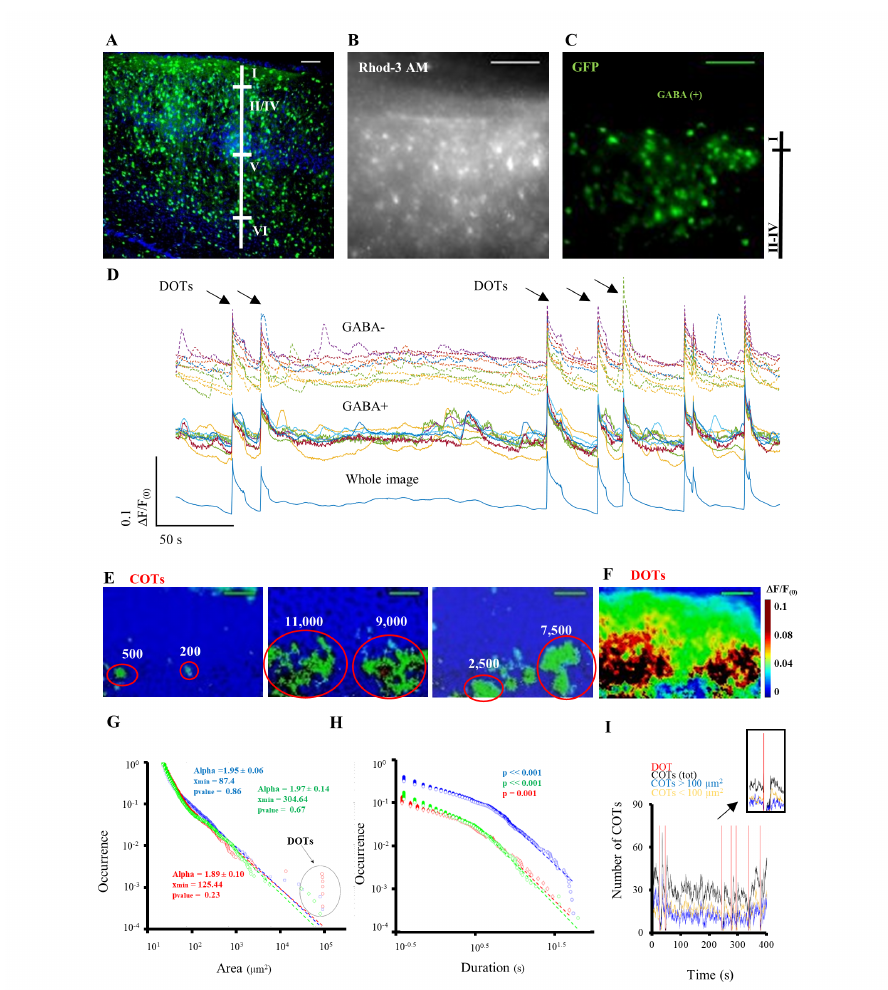
Figure 1: Spontaneous calcium transients in the cortex. (A) Fluorescent image of cerebral cortex from a GAD67-GFP mouse (P5) with DAPI nuclear staining; GABA+ neurons are labeled in green. The white vertical bar indicates the putative layers. (B) Organotypic slice from the same mouse line loaded with the fluorescent indicator Rhod-3 AM during calcium imaging, and corresponding GABA+ neurons (C) in the same field of view. The black vertical bar on the right indicates the approximate limits of cortical layers in this example. (D) ΔF/F (0) traces from the whole image (blue trace at the bottom, defined as ΔF/F network ) and from selected GABA+ (colored traces in the middle) and GABA- neurons (colored traces on top) from a calcium imaging recording. (E) Examples of Confined Optical Transients (COTs) from the pseudo-color ΔF/F (0) movie of the recording, showing isolated regions of variable sizes (see red circles; the rounded numbers are expressed in µm 2 ). (F) Example of Diffuse Optical Transient (DOT), where the increase in ΔF/F network involves more than 50% of the imaged slice. Color bar on the right. Scale bars: 80 µm in both fluorescence and pseudo-color images. (G, H) Probability distribution of area and duration of COTs in the cortex. Circles, rhombus and asterisks represent data from three representative experiments: the corresponding dotted lines in (H) show the linear fitting for each distribution. DOTs are visible as resonances outside the area’s distributions (see black circles). Insets indicates test of power law hypothesis and, only if p > 0.1, power point slope (alpha) and onset. (I) Density of COTs over time for different area sizes (COTs < 100 µm 2 and COTs > 100 µm 2 , yellow and blue line respectively) and for all sizes (black line) with reference to DOTs occurrence (red vertical lines). The inset shows the decrease in COTs density corresponding to DOTs’